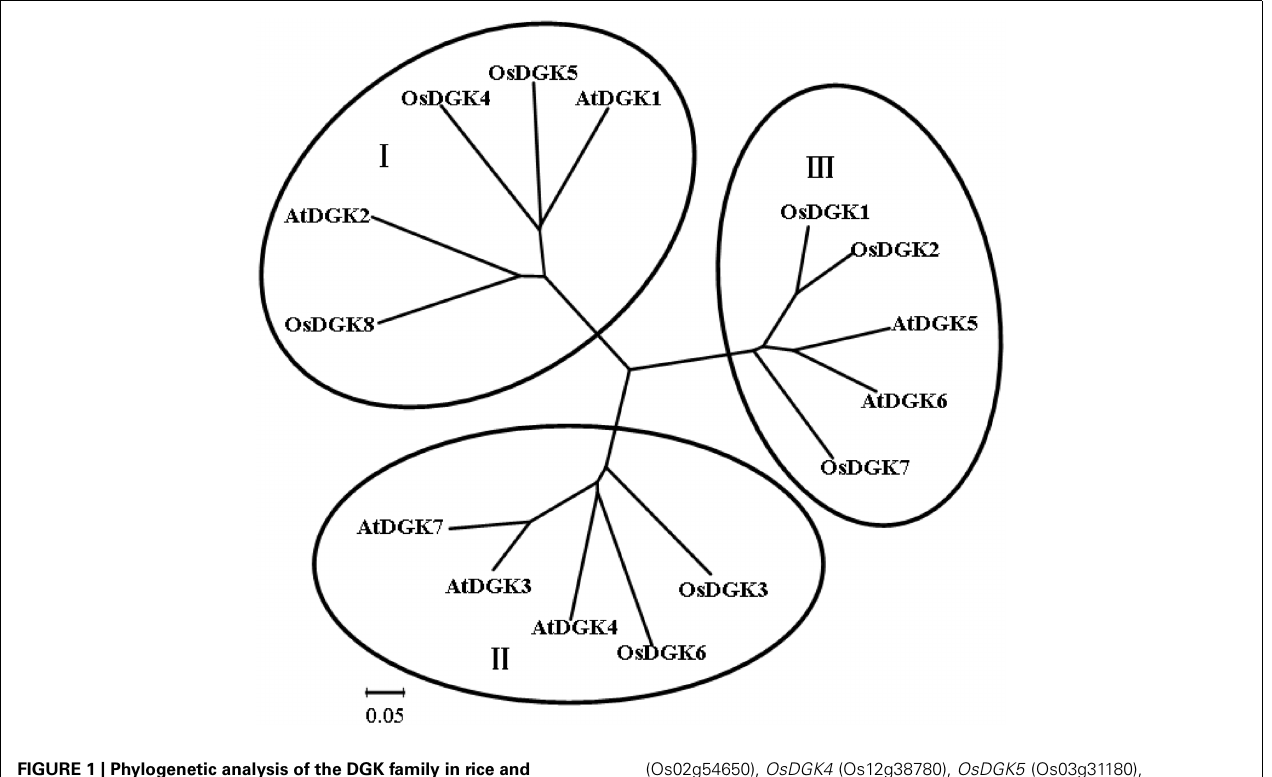
FIGURE 1 | Phylogenetic analysis of the DGK family in rice and Arabidopsis . Accession numbers for the DGKs are as follows: AtDGK1 (At5g07920), AtDGK2 (At5g63770), AtDGK3 (At2g18730), AtDGK4 (At5g57690), AtDGK5 (At2g20900), AtDGK6 (At4g28130), and AtDGK7 (At4g30340); OsDGK1 (Os04g54200), OsDGK2 (Os08g08110), OsDGK3